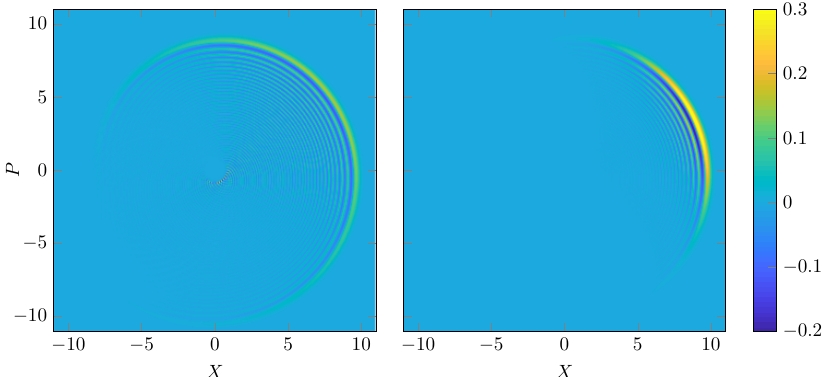
Figure 3. Wigner function snapshots of a typical single exact trajectory (obtained by numerical integration in truncated Fock space) after t = 0.1 γ − 1 phase diffusion out of an initial coherent state ( F / γ = 0, U / γ = 1, ∆ / γ = 100), for photon-counting ( left ) and heterodyne detection ( right ). It is clear to see that these states are not XP -Gaussian, firstly because they are bent and